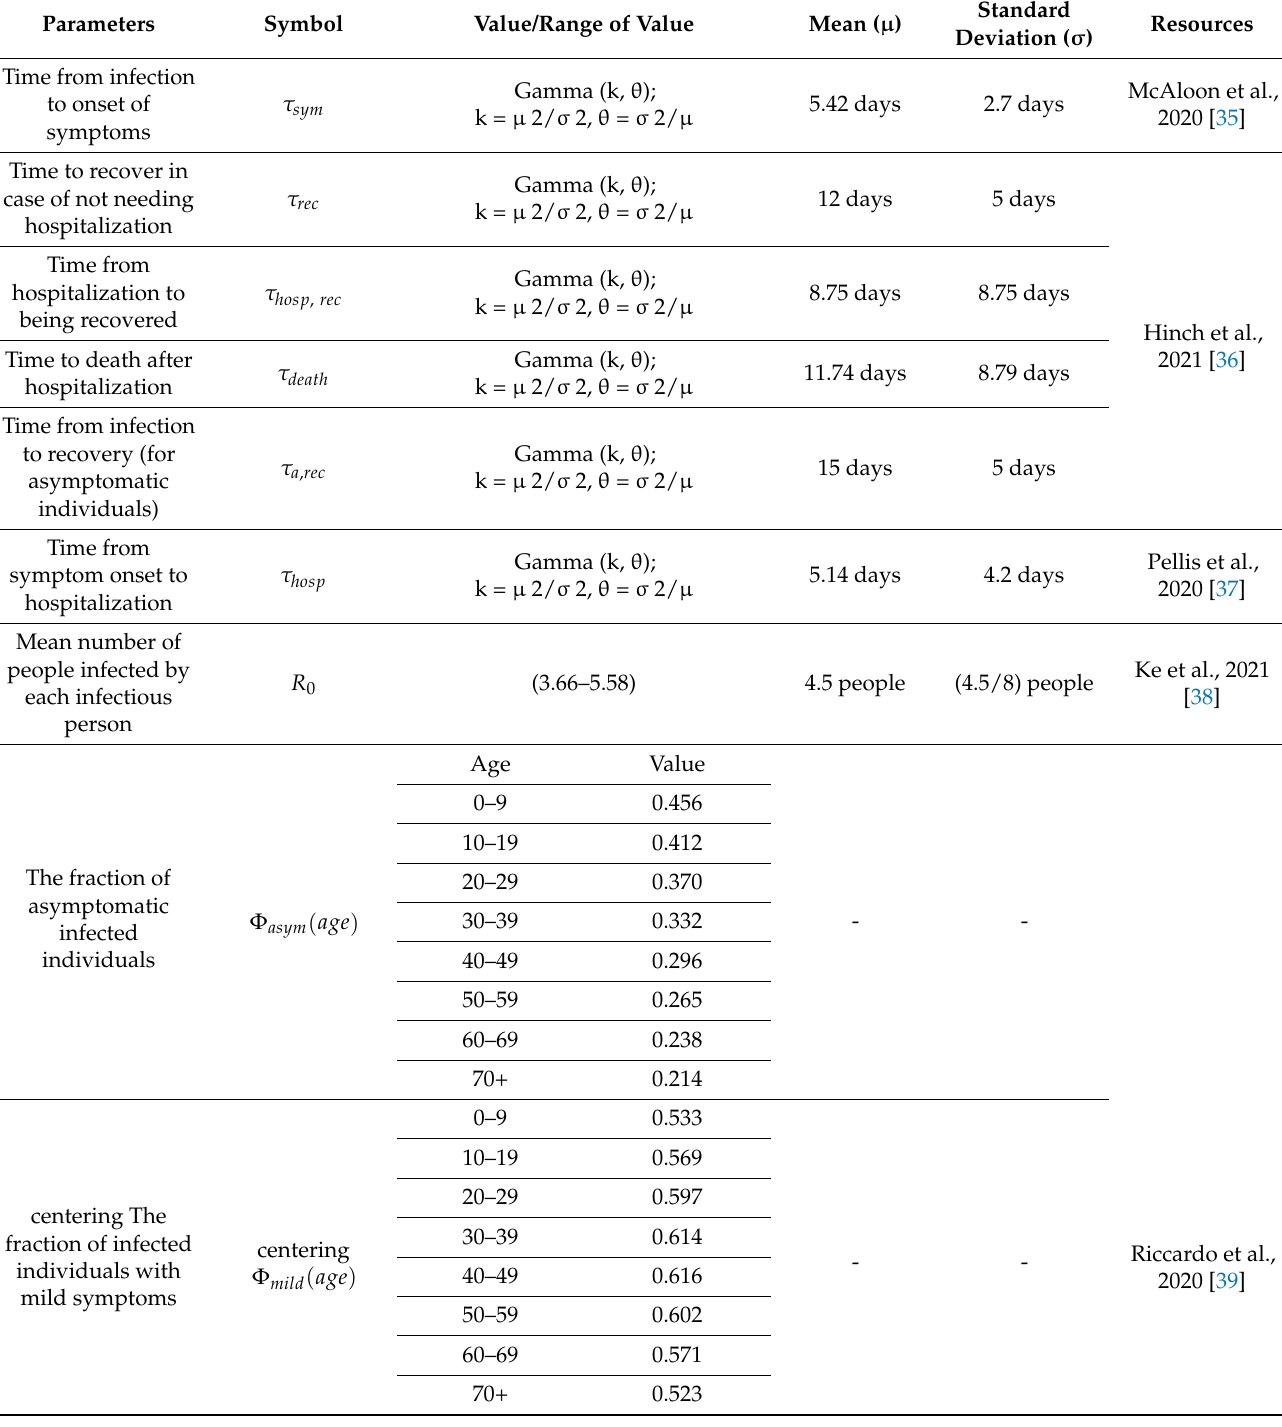
Table 1. Summary of the input